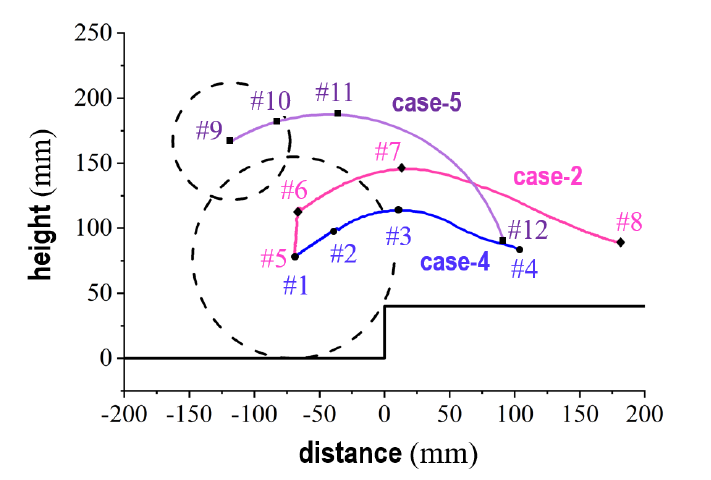
Figure 19. Comparison results for trajectories of axle and wheel’s center location when climbing a step where case-2, case-4, and case-5 denote the wheel with vertically translated axle, the proposed wheel, and the three-wheel device, respectively.